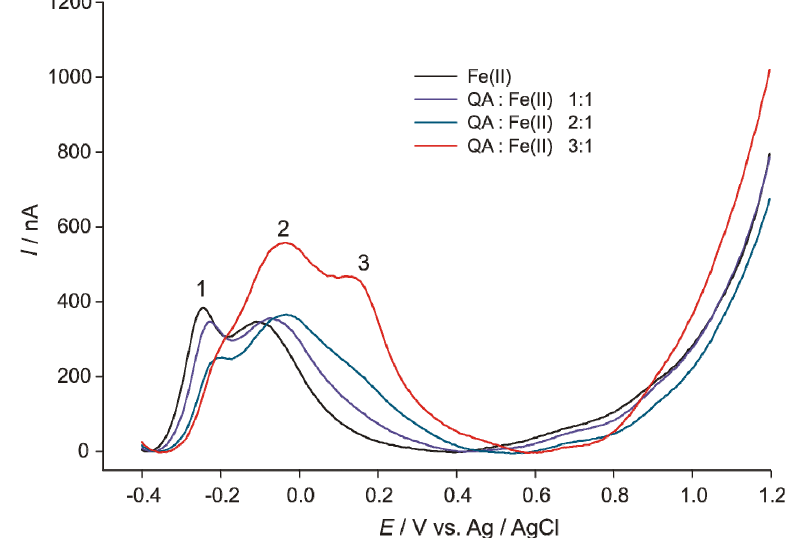
Figure 1. Differential pulse voltammograms of Fe(II) and 2,3-pyridinedicarboxylic acid (QUIN):Fe(II) 1:1, 2:1 and 3:1 of solutions in phosphate buffer, pH 7.4; for details, see the Experimental